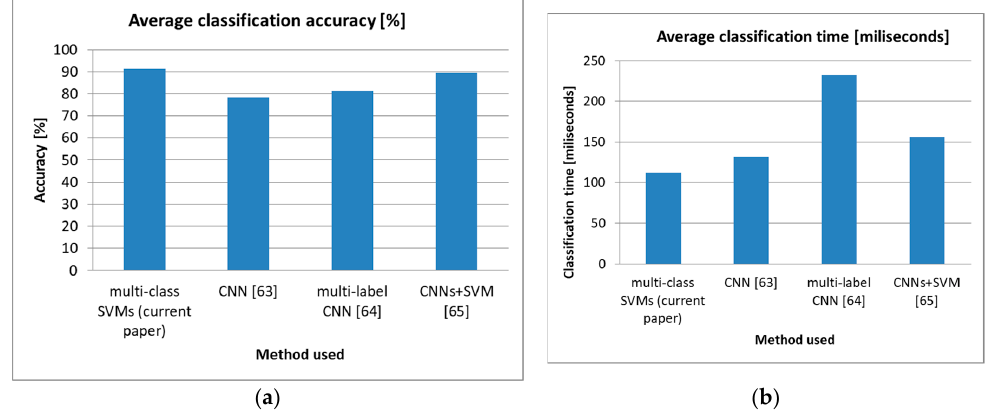
Figure 3. Comparison of state-of-the-art methods for AU classification. ( a ) Average classification accuracy [%], ( b ) Average classification time [miliseconds].